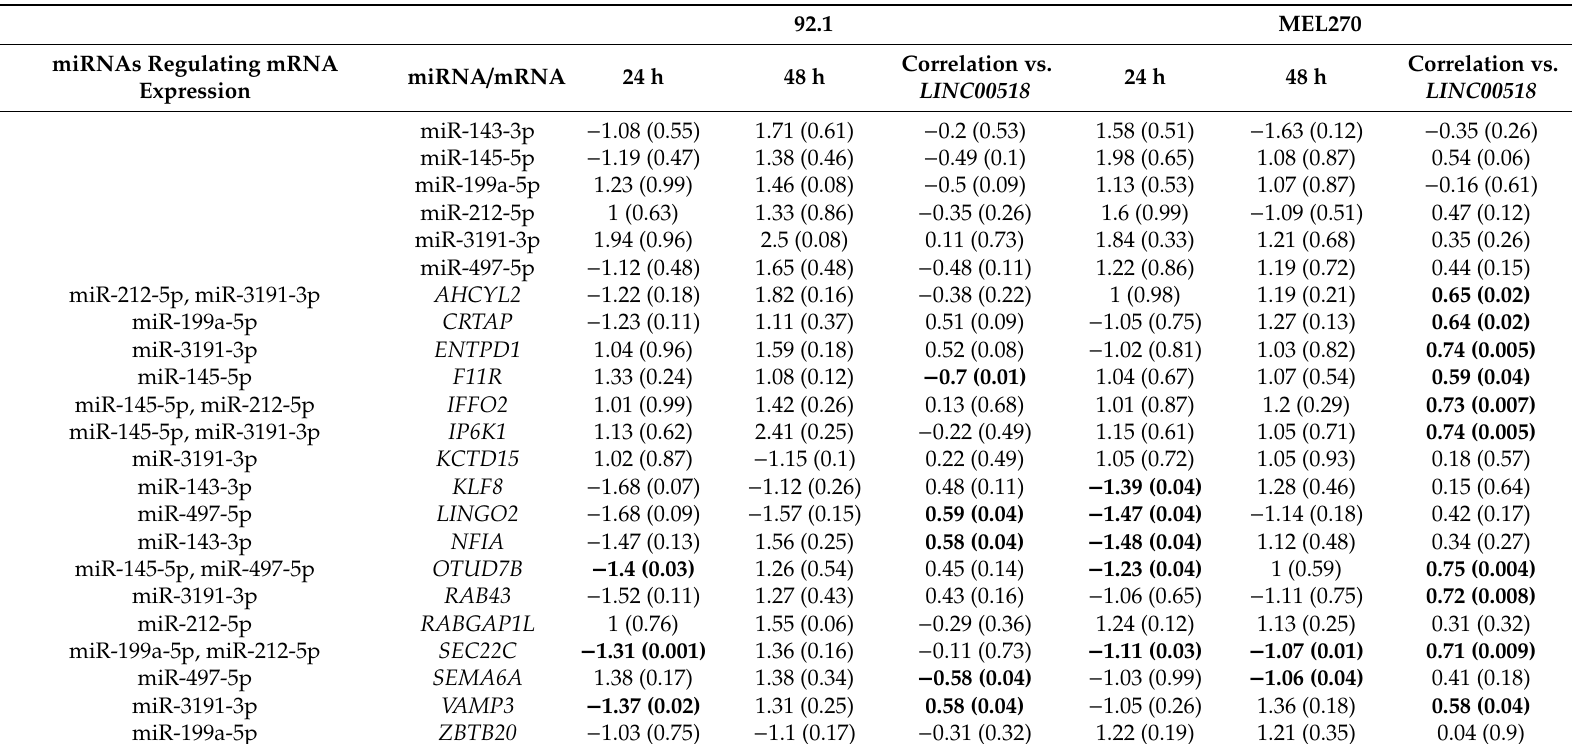
Table 1. Expression of miRNAs potentially sponged by LINC00518 and their mRNA targets after siRNA